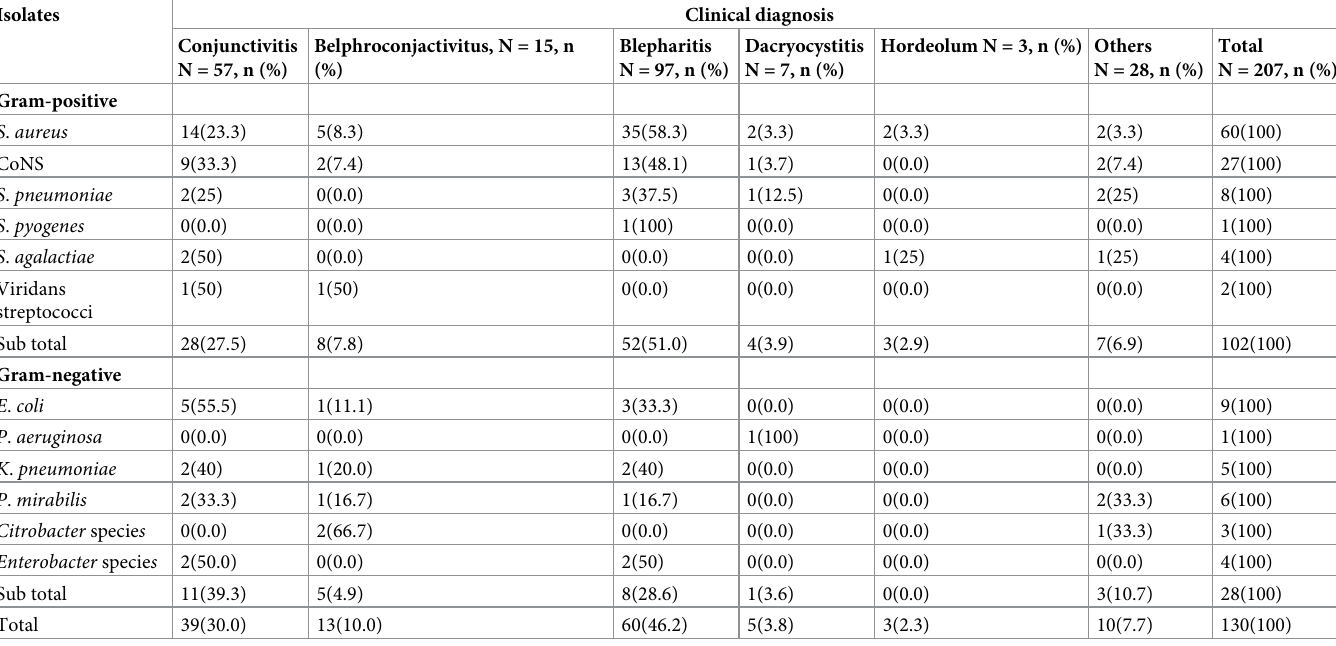
Table 2. Distribution of culture-confirmed bacterial isolates stratified by type of EOI at DMCSH, Northwest Ethiopia, 2021. Isolates Clinical diagnosis Conjunctivitis N = 57, n